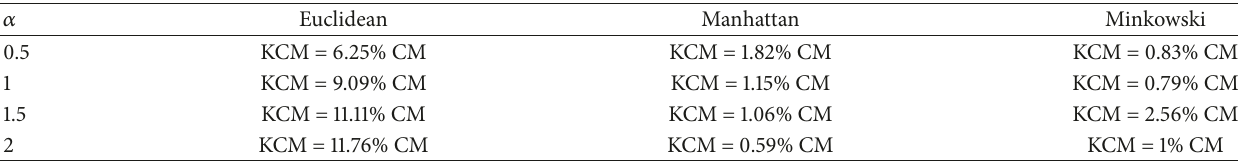
Table 1: The time processing of CM versus KCM with Euclidean, Manhattan, and Minkowski ( 𝑝 = 1.5) distances when the number of clusters is